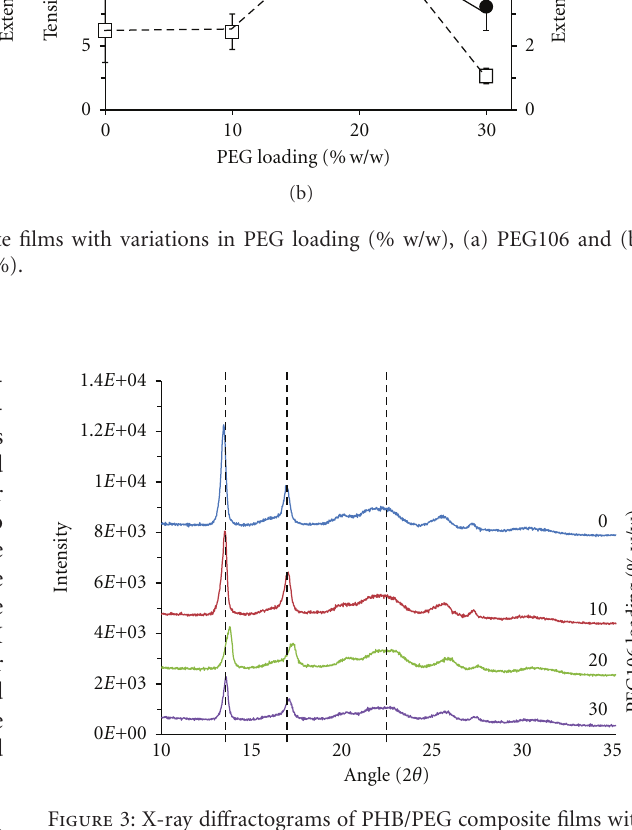
Figure 3: X-ray di ff ractograms of PHB/PEG composite films with variations in PEG106 loading (% w/w).